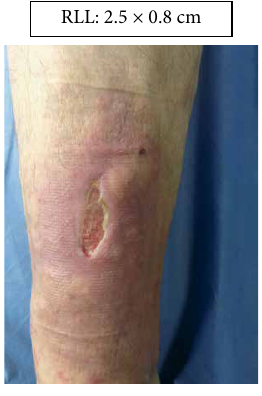
Figure 18: Week 5. Lower right limb.